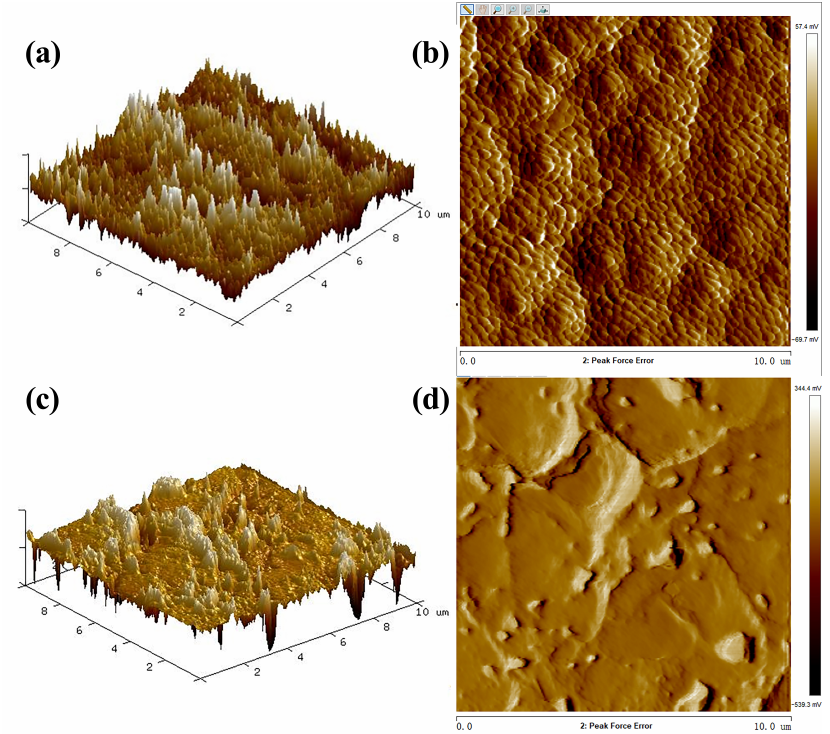
Figure 6. AFM images of surface of the ( a , b ) raw PVDF membrane and ( c , d ) g- TiO 2 /PVDF C 3 N 4 /Ag 3 PO 4 /TiO 2 /PVDF membrane.